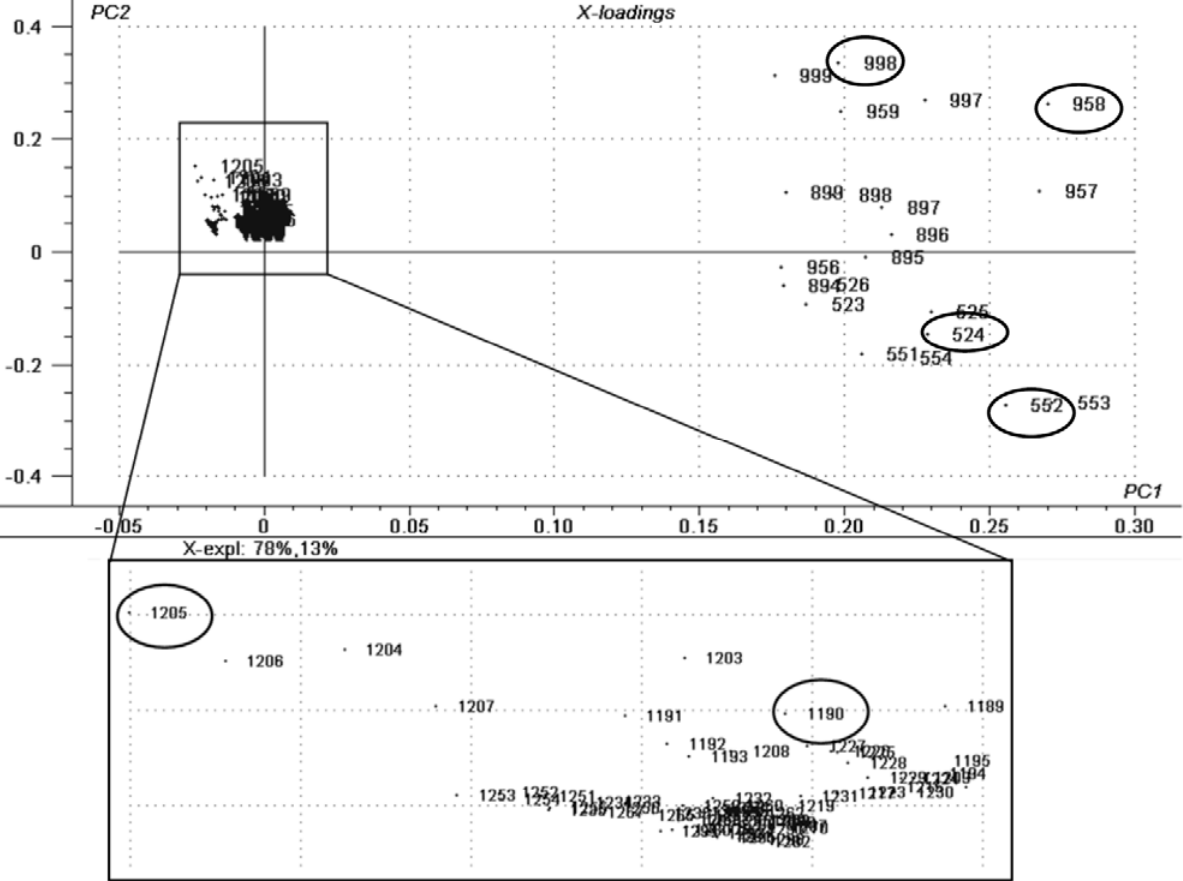
Figure 2. Correlation loadings plot for the principal components in lipstick samples: m/z range of 520–560 (diacylglicerols (DAGs)) for the expired product, m/z range of 890–1000 (higher triacylglycerols (TAGs)) for the “in-use” products and m/z range of 1100–1210 (ceramides) for the new products. The marked ions were the ones chosen as biomarkers for each degradation